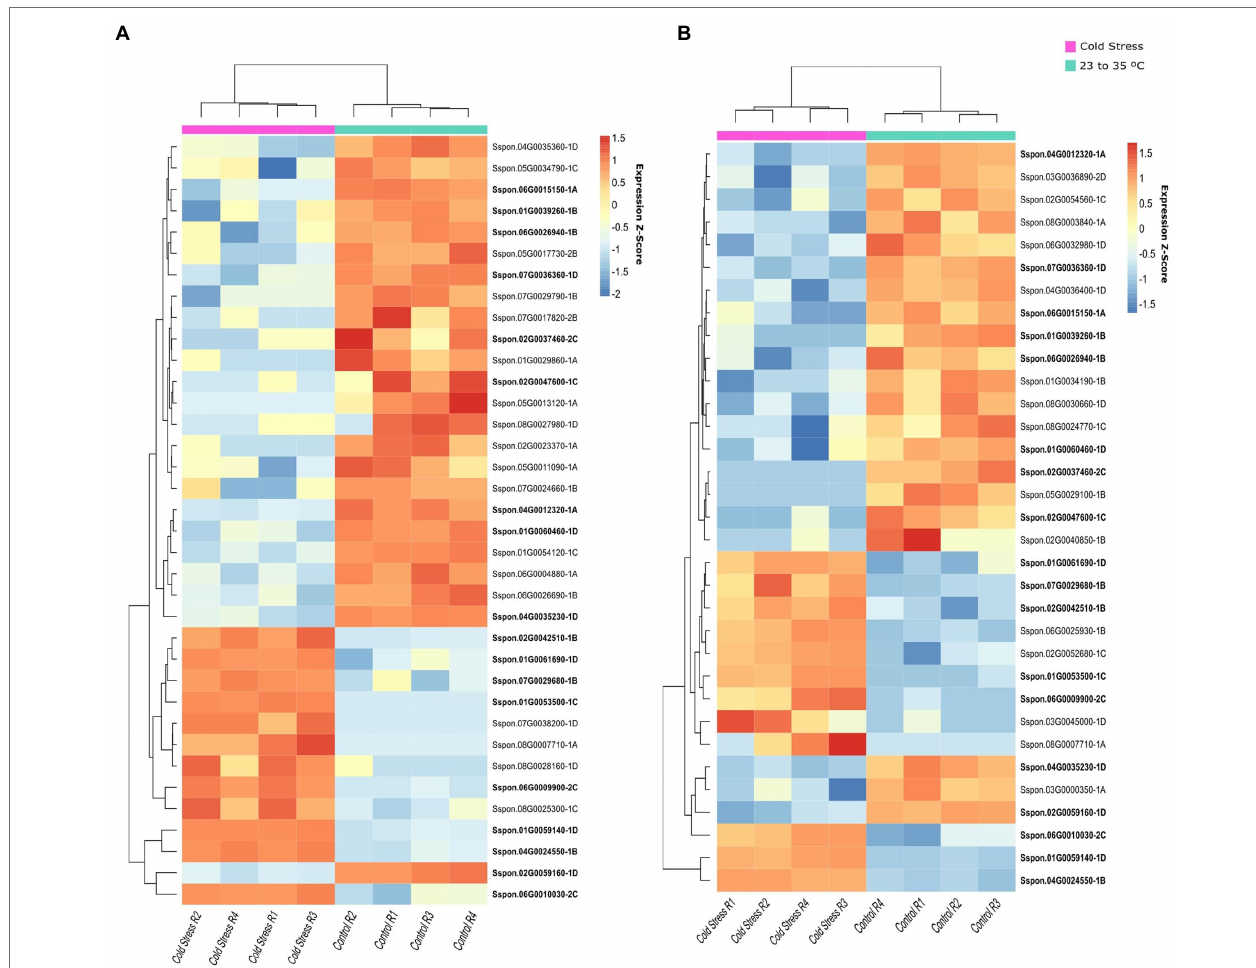
FIGURE 3 | Orphan genes (OGs) differentially expressed (DE) under cold stress. Hierarchical clustering of the genes expressed at normal and cold temperatures with four replicates for each treatment (row). DE analysis was carried out in leaf tissues at an ambient temperature (ranging from 23 ° C to 35 ° C) and a cold temperature (4 ° C in a well-controlled climate chamber) in two sugarcane genotypes: ROC22 (A) and Guitang08-1180 (B)